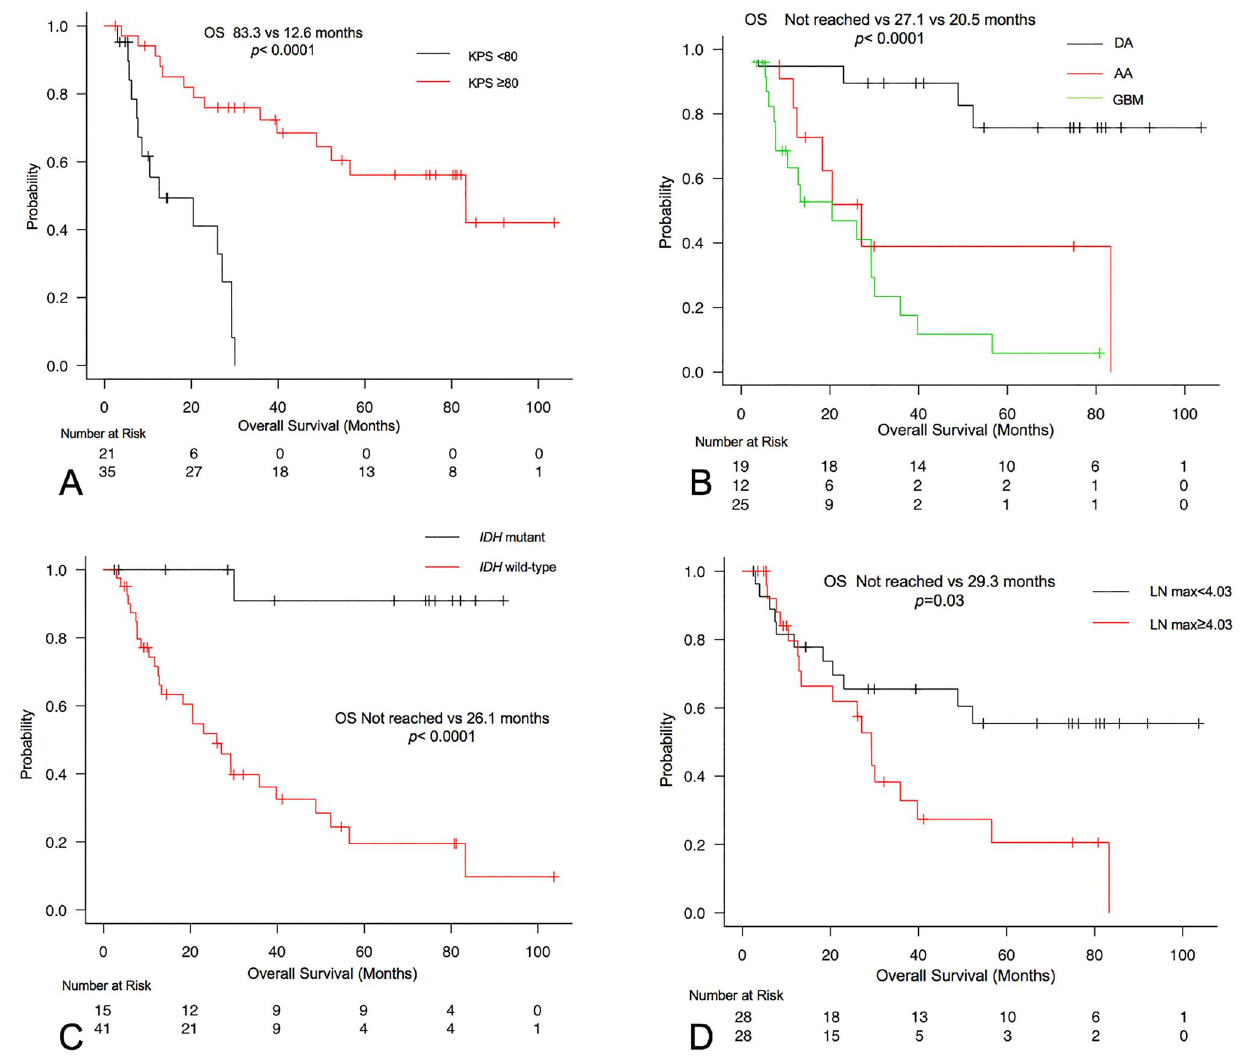
Figure 2. Kaplan–Meier plot of OS in relation to preoperative KPS ( A ), histology ( B ), IDH status ( C ), and LN max ( D